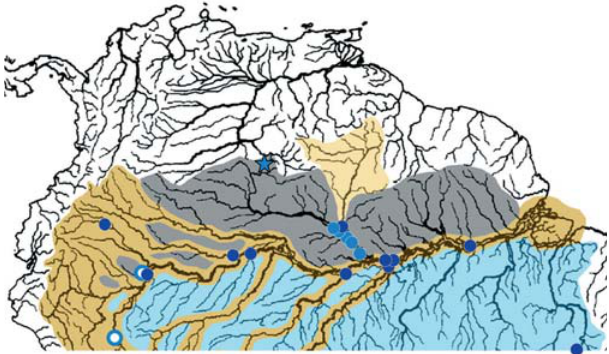
Fig. 25. Distributions of Leptodoras cataniai (solid light blue circles, star denotes type locality), L. cf. cataniai Amazon form (solid dark blue circles) and L. cf. cataniai Nanay form (open